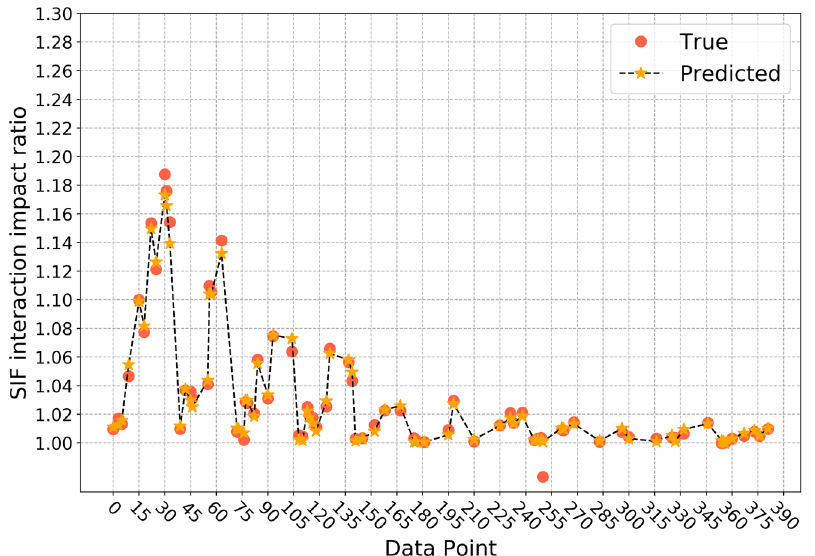
Figure 7. Prediction results of SIF interaction impact ratio based on approach 1.